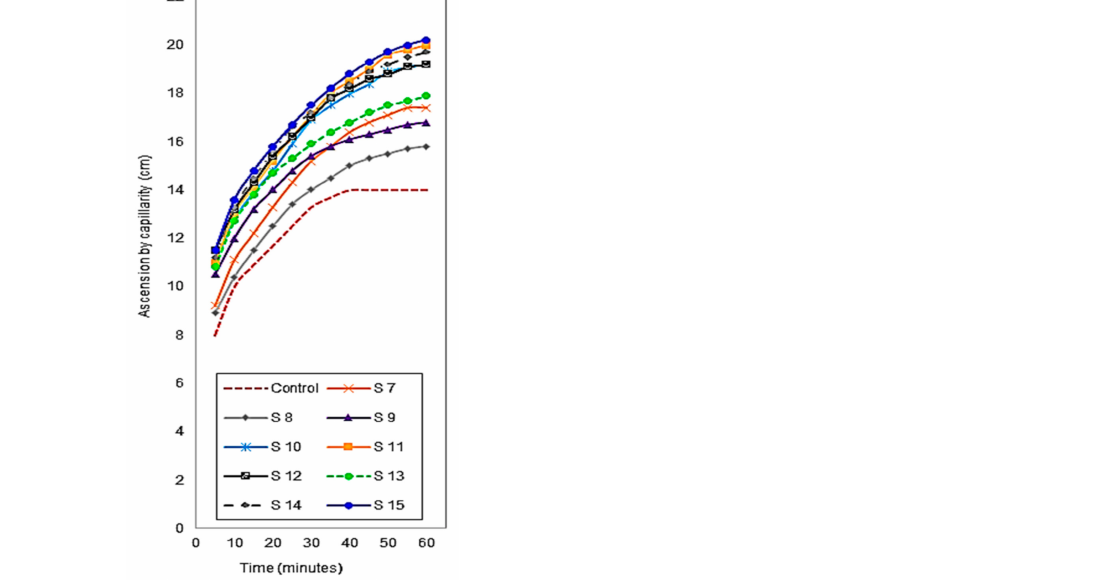
Figure 8. Curve of capillary ascension for some samples: control sample, S7–S15; (same codes as in Table 2).